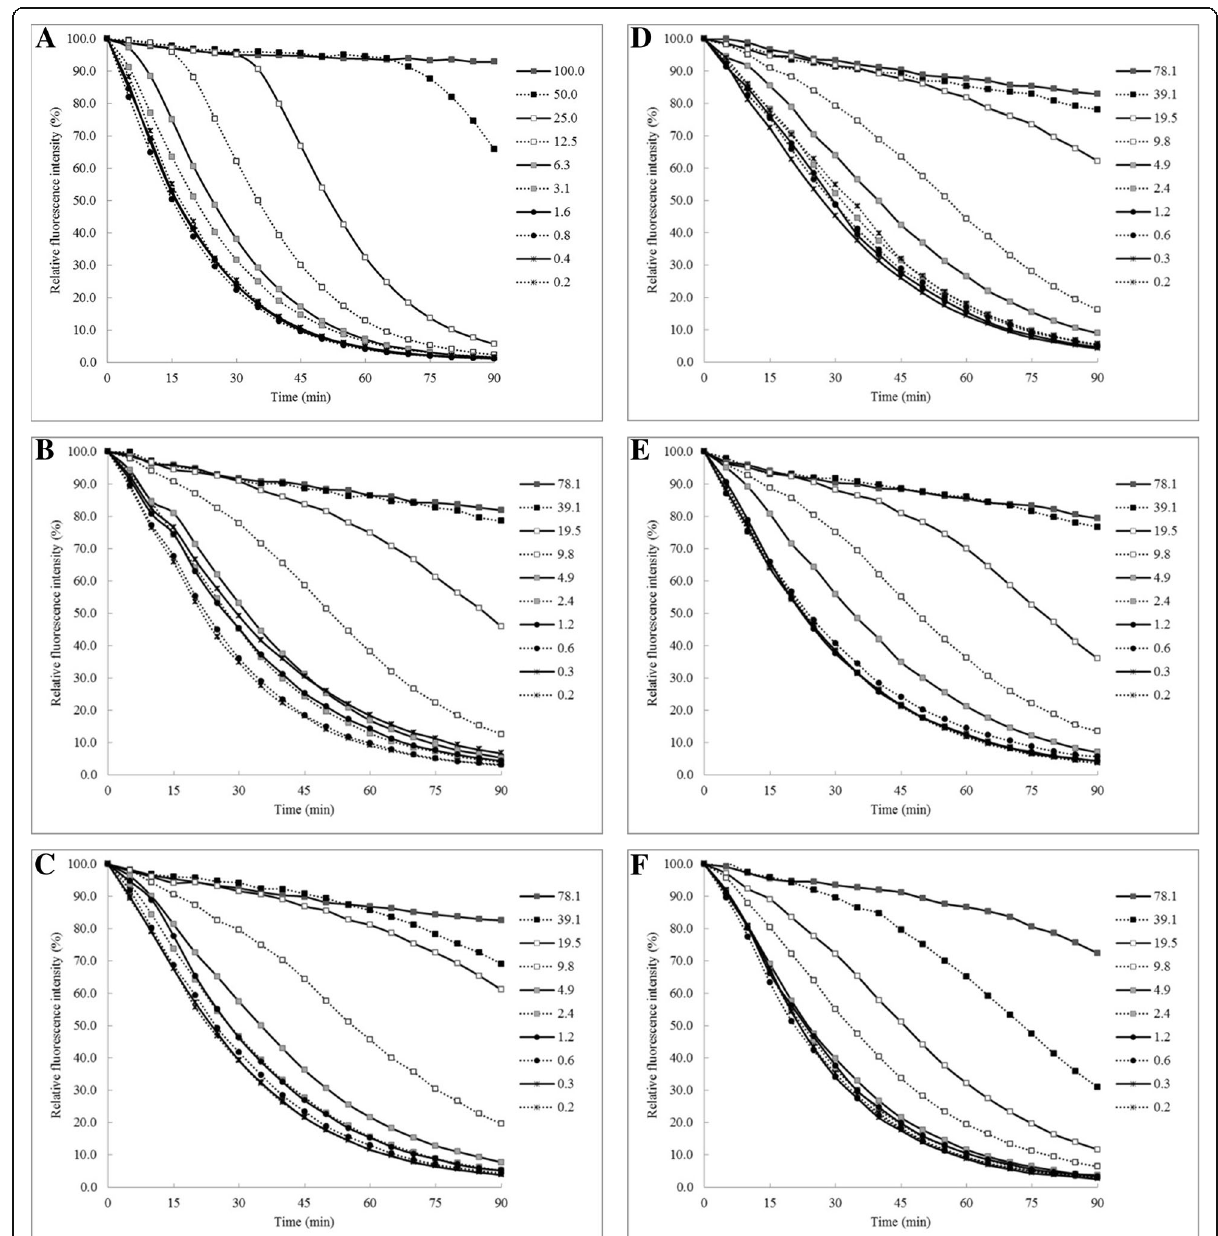
Fig. 1 Fluorescence decay curves induced by AAPH in the presence of trolox (a positive control: a ) at 100 – 0.2 μ g/mL and water extracts of Jatu-Phala- Tiga ( b ), Phyllanthus emblica ( c ) Terminalia arjuna ( d ), Terminalia bellirica ( e ), and Terminalia chebula ( f ) at 78 – 0.2 μ